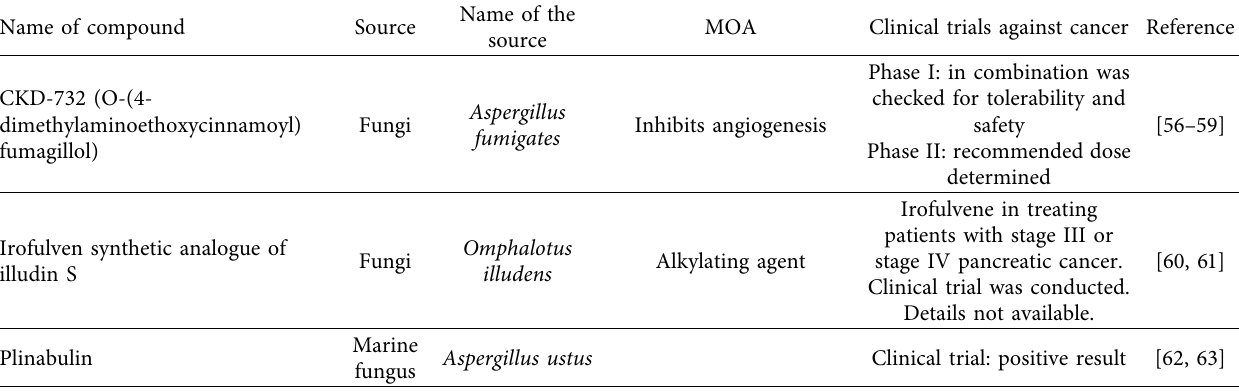
Table 3: Anticancer agent that shows chemotherapeutic properties on various cell